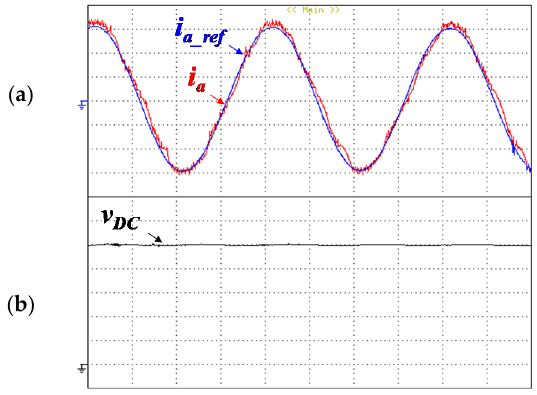
Figure 35. G2V slow battery-charging mode: ( a ) grid current and reference current; ( b ) dc-link voltage (current: 2 A; voltage: 20 V/div; time: 5 ms/div).